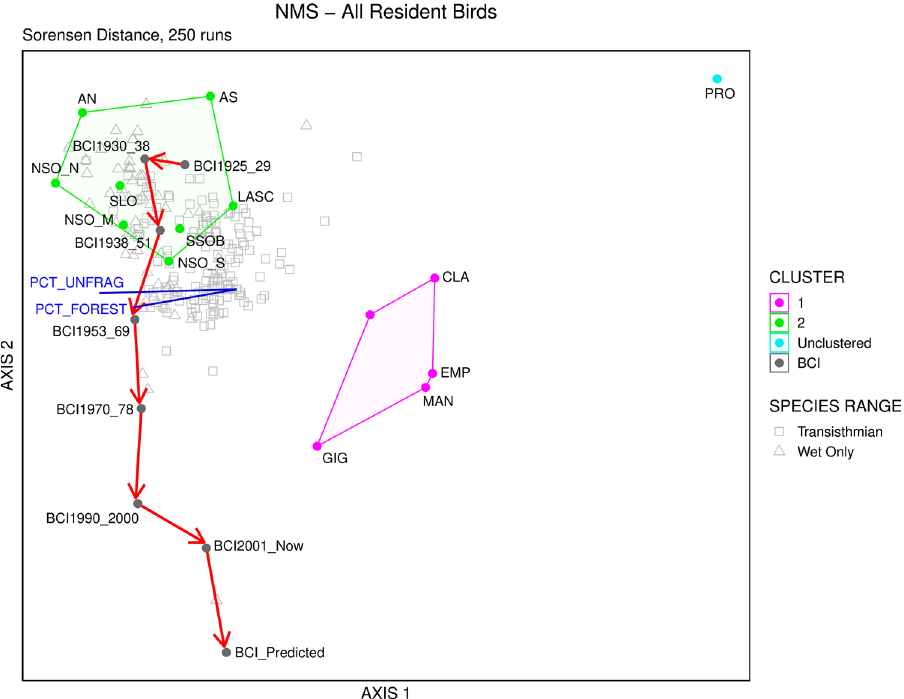
Figure 4. NMDS ordination of species and sampling units in species space. Subregions indicated by abbreviations, with colored dots corresponding to group membership based on hierarchical cluster analysis (Fig. 3). Numbers after BCI indicate census period. Bird species are represented by hollow gray shapes. Squares denote transisthmian birds—those occurring along the entire Panama Canal; triangles represent birds that occur in exclusively wet, Atlantic subregions. Red line is a successional vector connecting BCI censuses in chronological order. Dark blue lines and text indicate the strength and direction of significant associations between environmental variables and